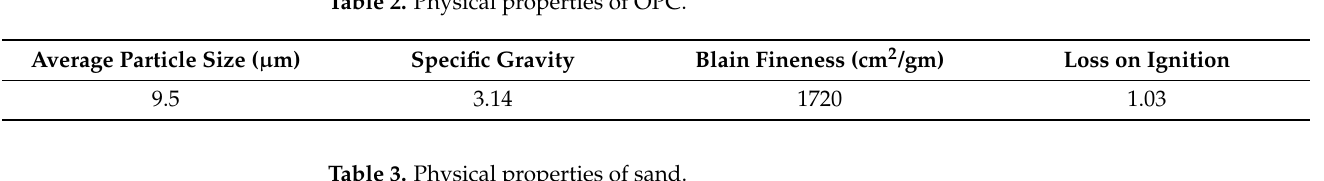
Table 2. Physical properties of OPC.